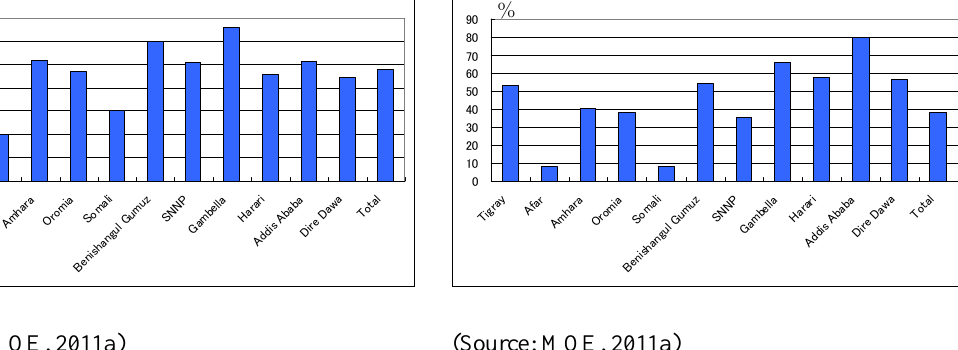
Figure 4-7: Primary Gross Enrollment Rates by Region (2010/11)